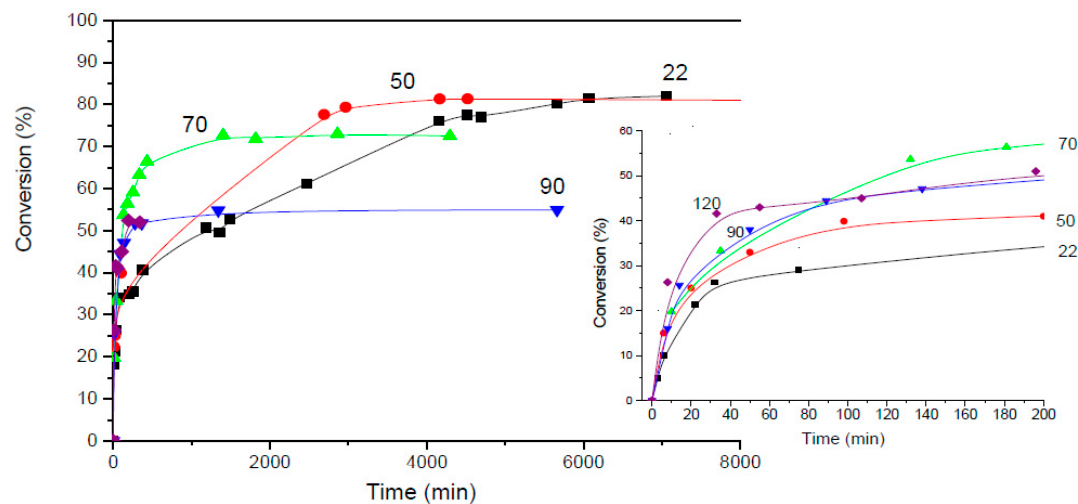
Figure 1. Conversion of the maleimide DPBMI during the reaction with F4D2000 in dioxane solution at different temperatures. Numbers indicate the temperature. Insert: early stage of the reaction.